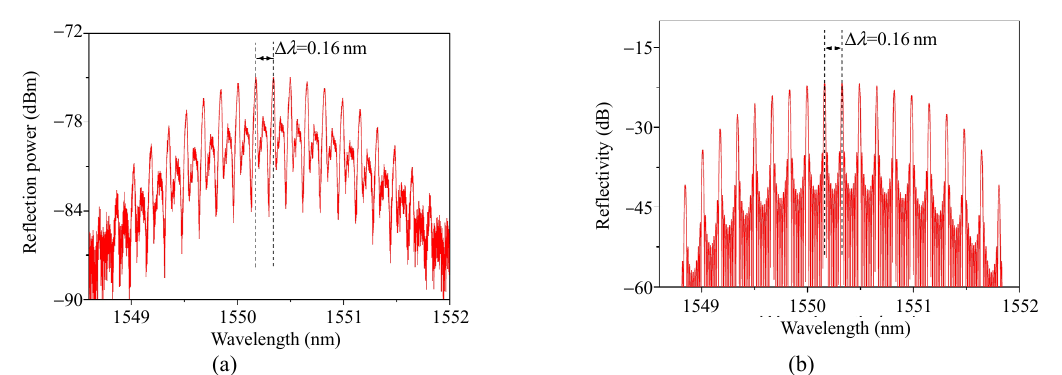
Fig. 2 Reflection spectrum (a) and the simulation spectrum (b) of the SFG prepared by the scanning